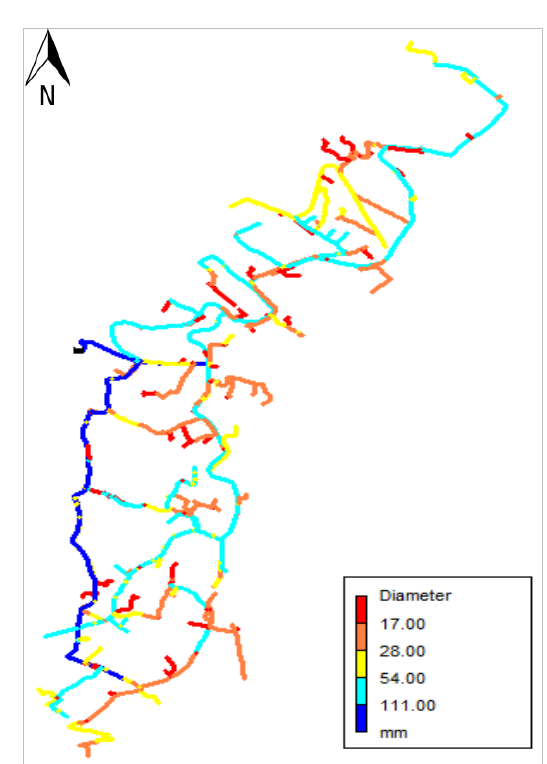
Figure 6 . Diameter distribution throughout the Gaula WDS . Figure 6. Diameter distribution throughout the Gaula